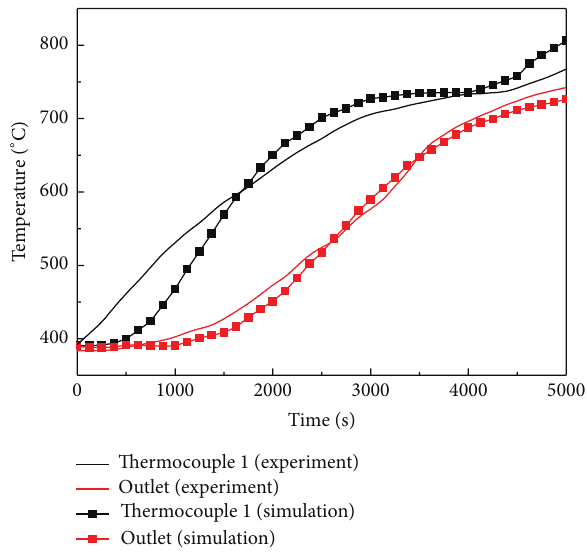
Figure 6: Comparison between the measured and the calculated temperature as a function of